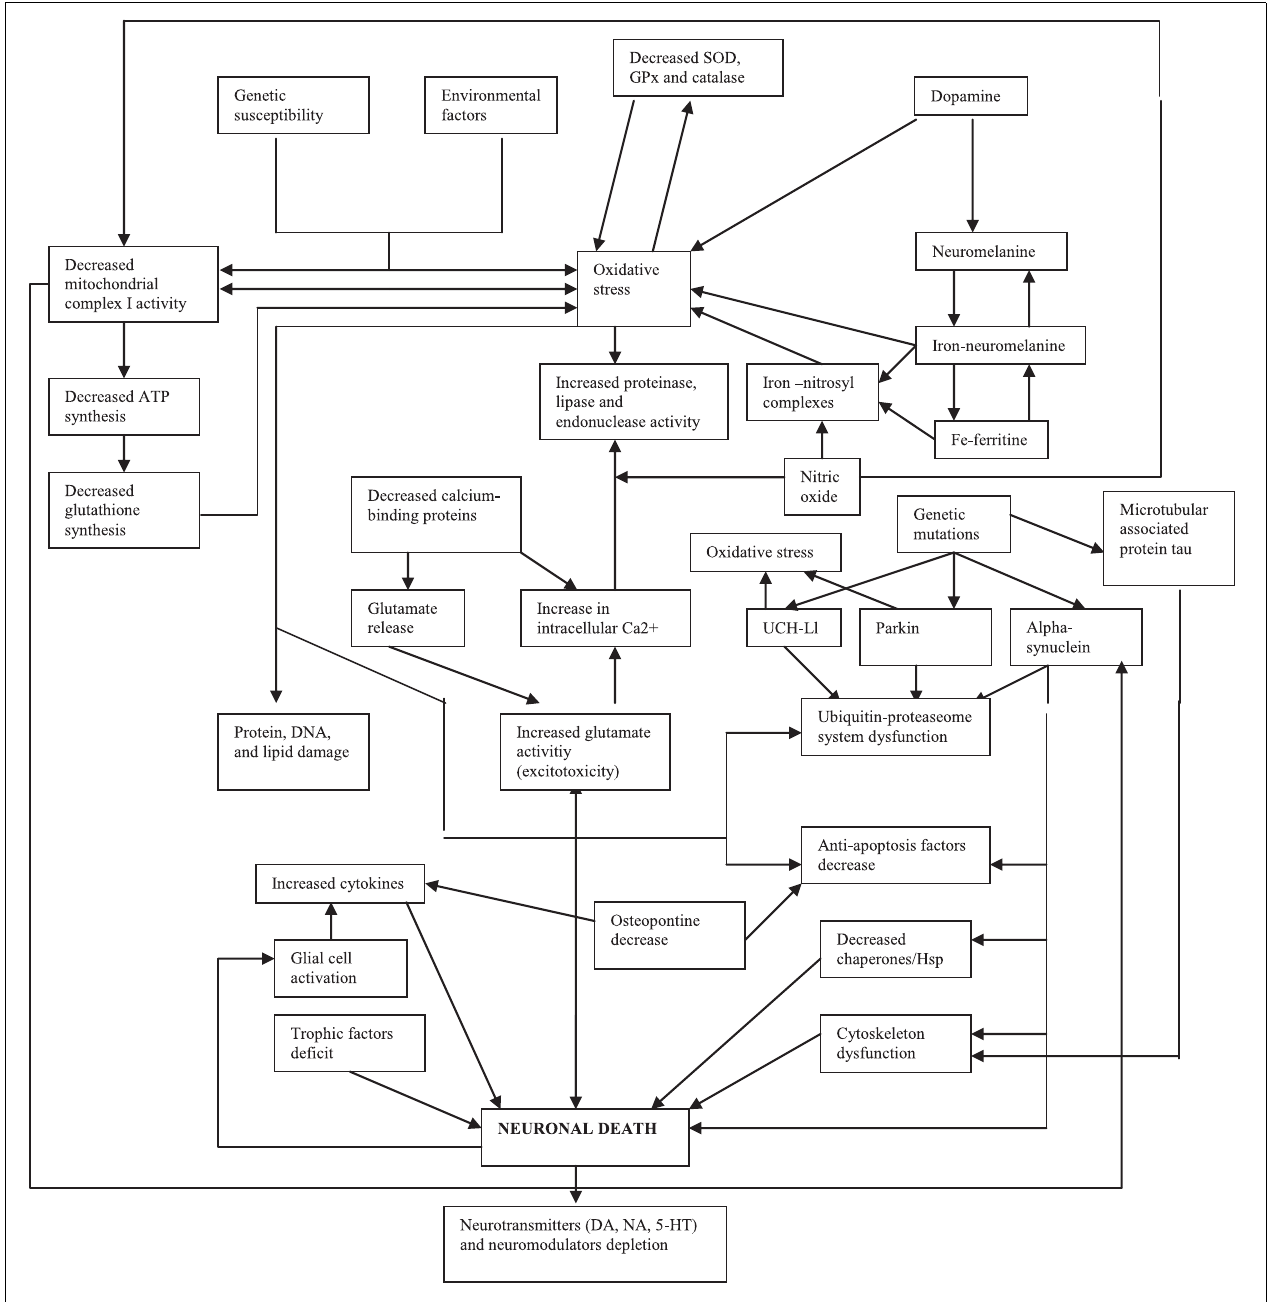
FIGURE 1 | Pathogenical mechanisms proposed for Parkinson’s disease (modified from Alonso-Navarro et al., 2008).